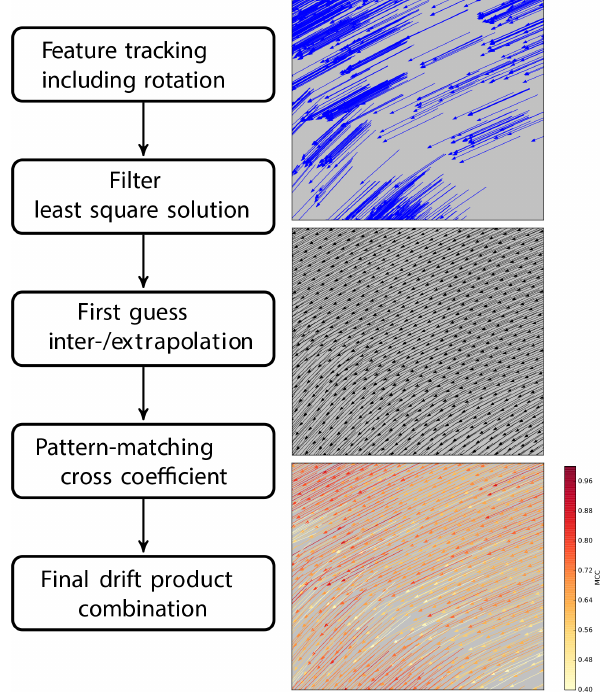
Figure 4. The flow chart on the left depicts the five main steps of the algorithm. The right column illustrates the evolution of the drift re- sults using image pair Fram Strait in HV polarisation and a grid with 4km spacing. (NB The part of the image pair that is depicted here is marked with a dashed rectangle in Fig. 1.) Blue vectors are derived by applying an adjusted version of the feature tracking algorithm from Muckenhuber et al. (2016). Black vectors indicate the initial drift estimate (first guess) based on filtered feature-tracking vectors. The final drift product (yellow to red vectors) are derived from com- bining the first guess with pattern-matching adjustment and apply- ing a minimum cross-correlation value. A total of 4725 vectors have been found on image pair Fram Strait with a MCC value above 0.4 in